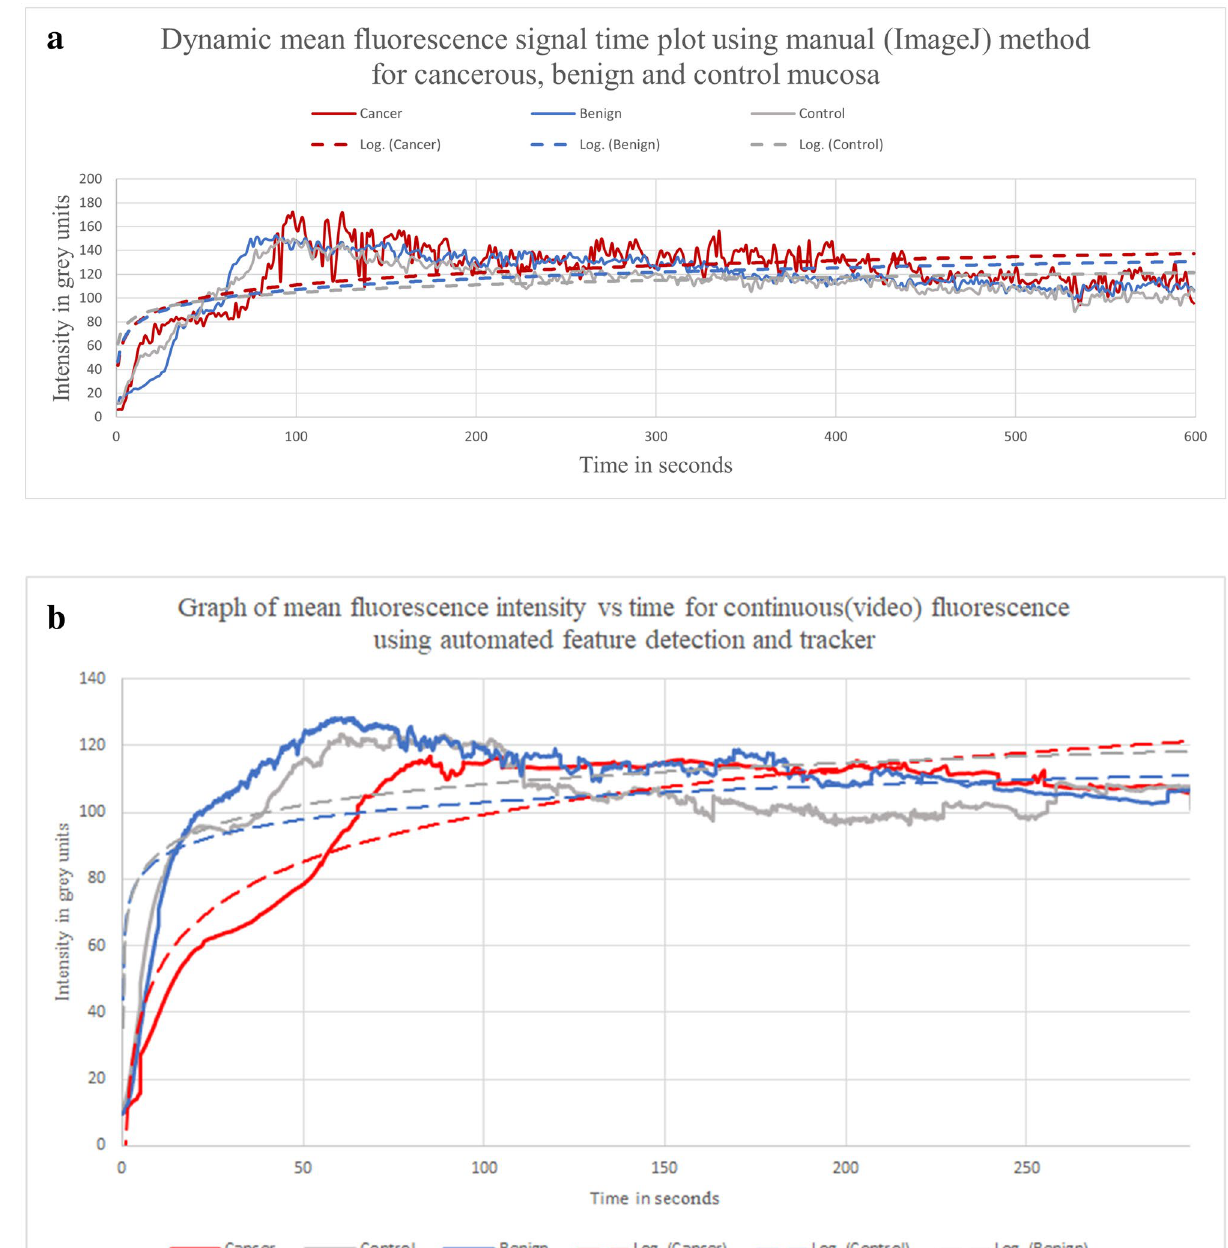
Figure 7. Graph (Microsoft Excel for Microsoft 365) of mean fluorescence intensity per frame vs time for continuous (video) in vivo fluorescence signals using ( a ) manual Image J methodology (1 fps) and ( b ) the Fluorescence Tracker App (30 fps) with automated feature detection and tracker in the video recordings of patients with both benign and malignant rectal lesions. Mean frame intensity for cancer/benign tumours and normal tissue (solid lines) and logarithmic fitted curves (dotted